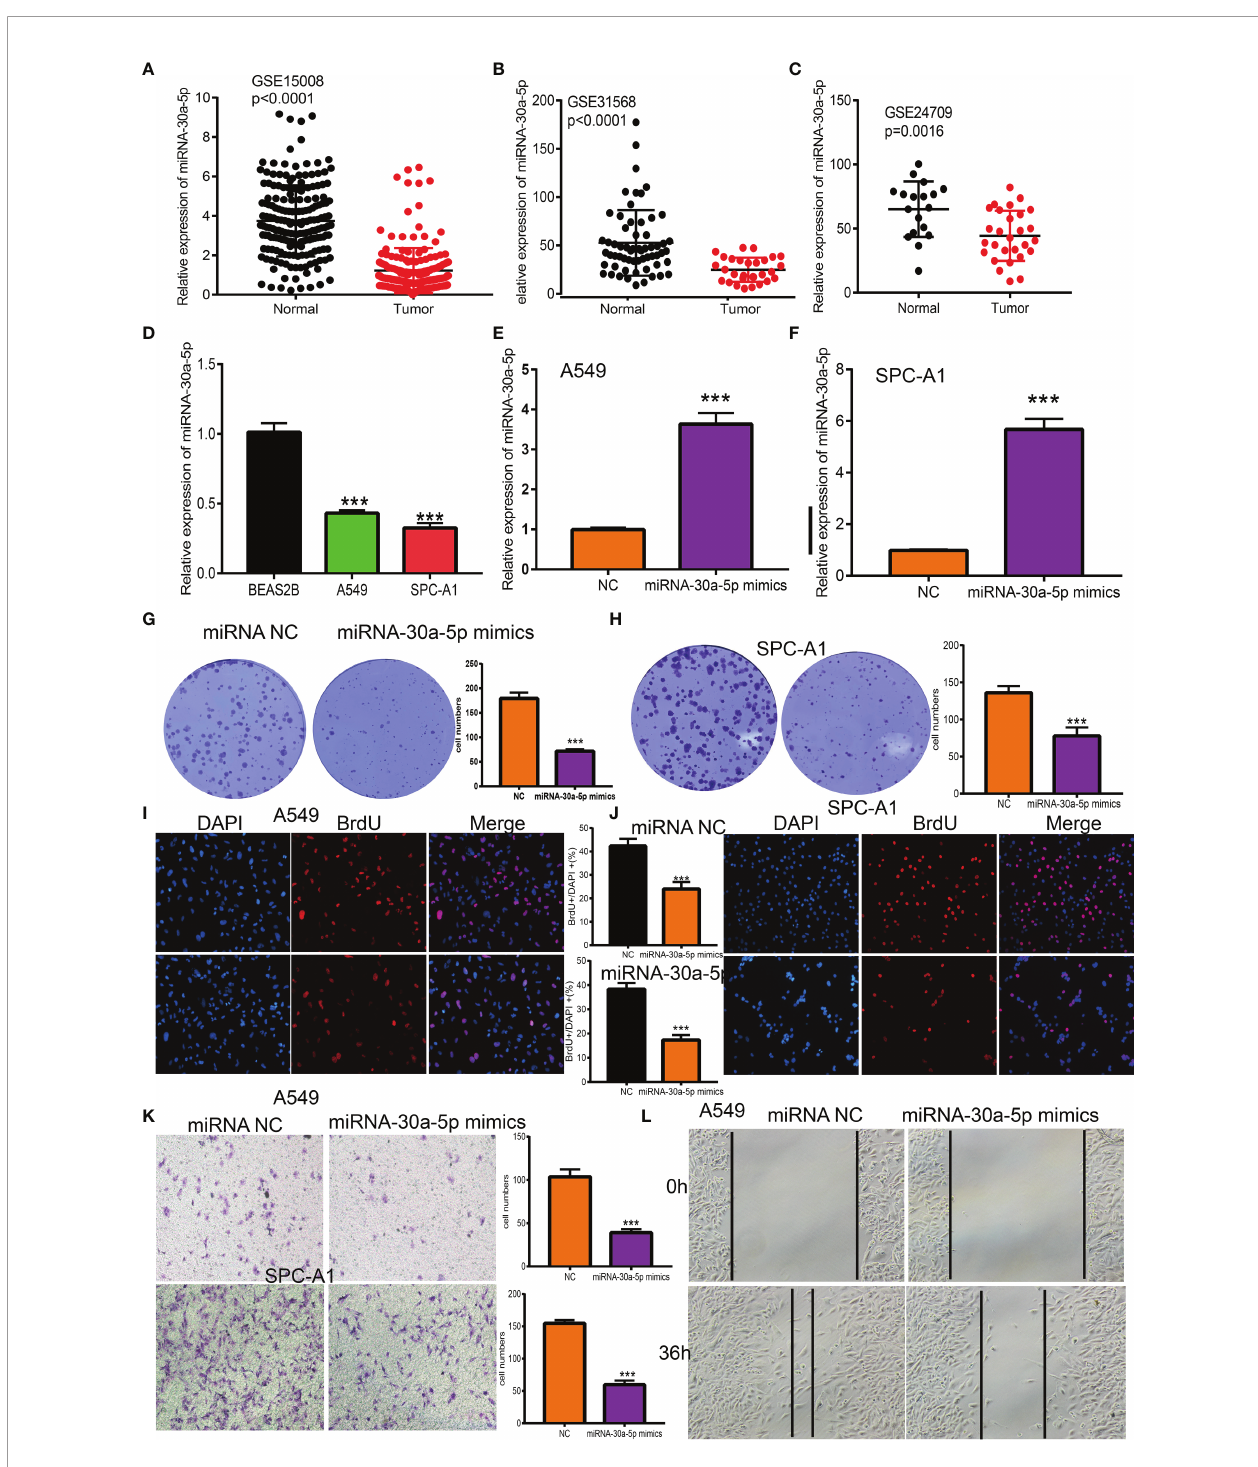
FIGURE 8 | Over-expression of miRNA-30a-5p inhibits the cell proliferation and migration ability of LUAD cells. (A – C) The expression of miRNA-30a-5p in LUAD was examined by GEO datasets. (D) The expression of miRNA-30a-5p in LUAD cell lines was examined by qRT-PCR assay. (E, F) The expression of miRNA-30a-5p in LUAD cells lines after over-expression of miRNA-30a-5p was examined by using the qRT-PCR assay. (G – J) Over-expression of miRNA-30a-5p on cell growth ability examined by clone information and BrdU assays. (K, L) Over-expression of miRNA-30a-5p on cell migration ability examined by transwell and wound healing assay. Quanti fi cation data were also indicated. Scale bar=50 mm. ***P <